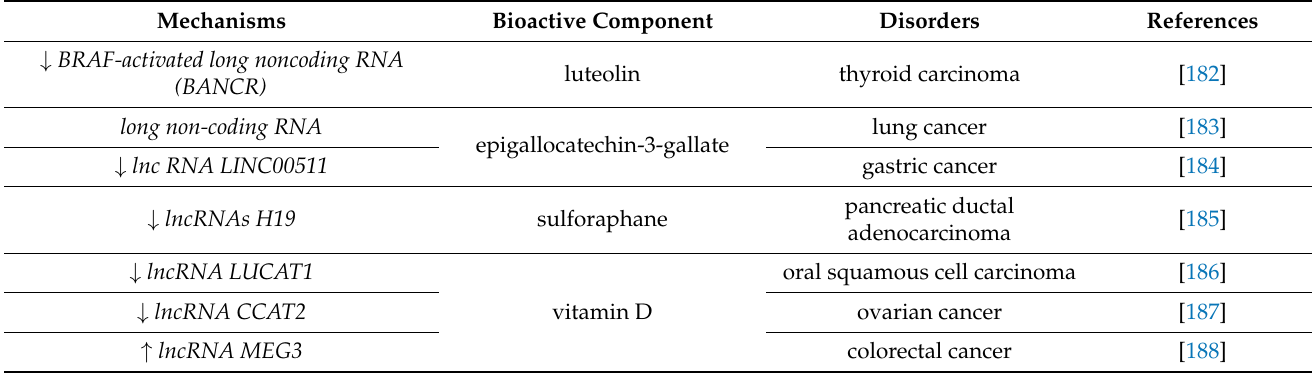
Table 3. Bioactive components of the diet and their role in lncRNA level